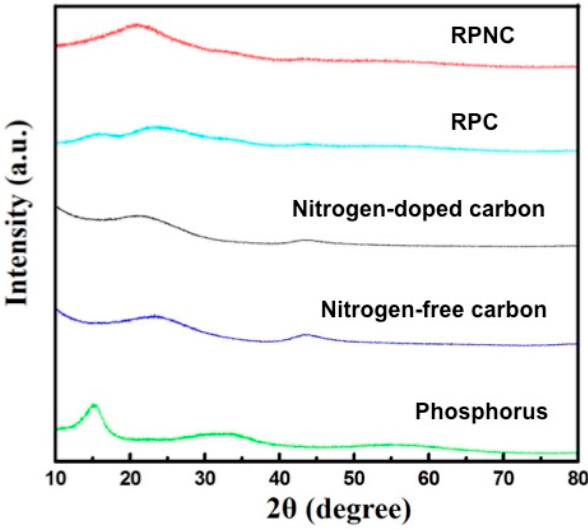
Figure 1. XRD patterns of elemental phosphorus, nitrogen-free carbon, nitrogen-doped carbon, and composites.